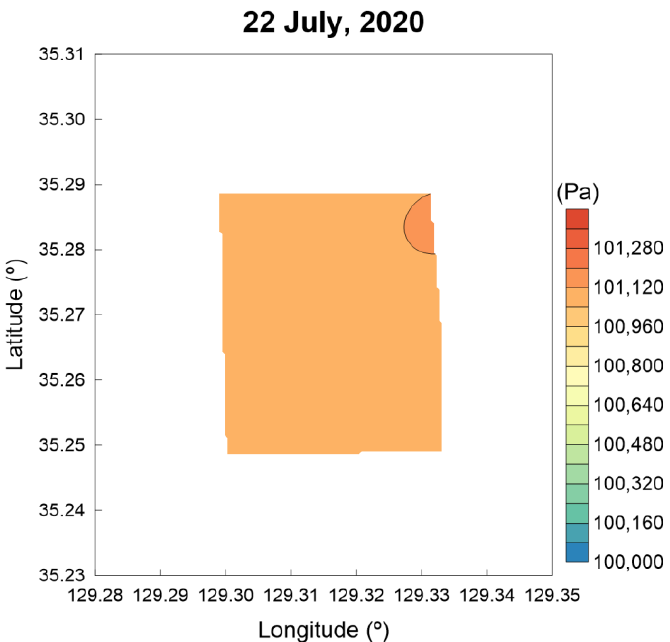
Figure 21. Distribution of atmospheric pressure in the Gijang coastal waters sea (22 July, 2020).